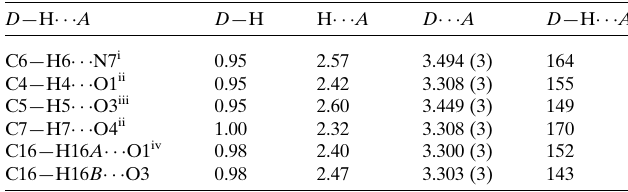
Table 1 Hydrogen-bond geometry (A˚ , (cid:4) ).